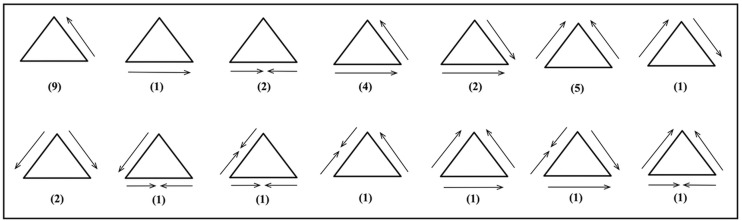
Trihedral configuration schemes.